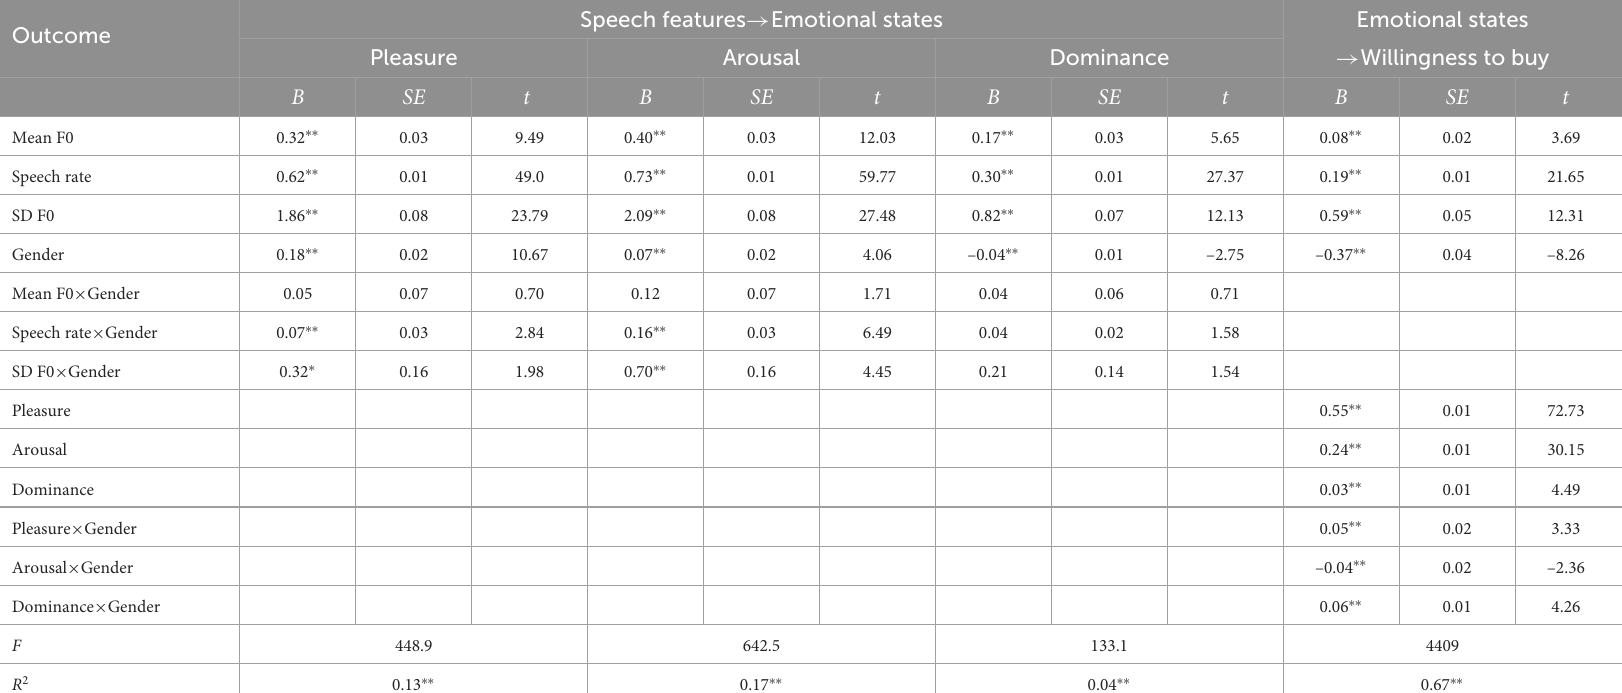
TABLE 5 Results of moderated mediation analysis for listeners’